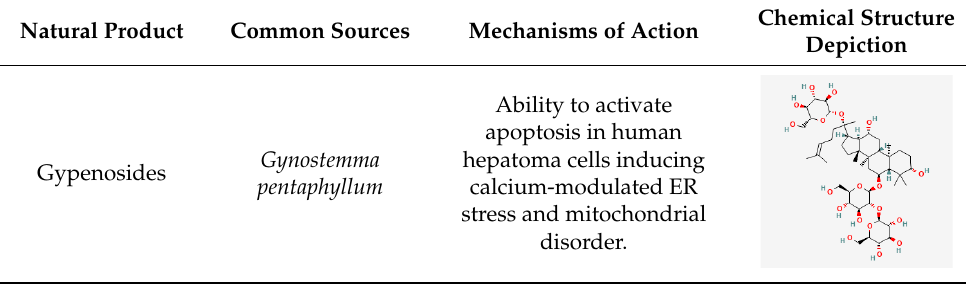
Table 1. Cont. Natural Product Common Sources Mechanisms of Action Gypenosides